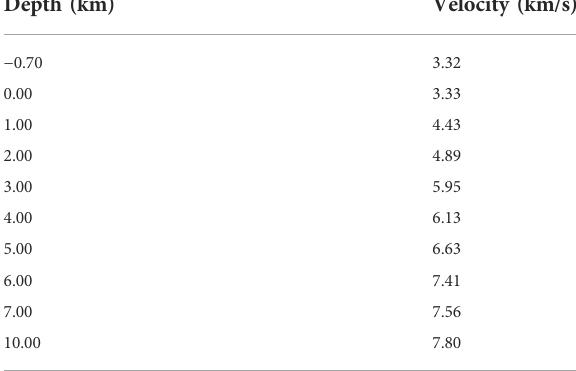
TABLE 1 Minimum 1D P-wave velocity model obtained by VELEST (see Section